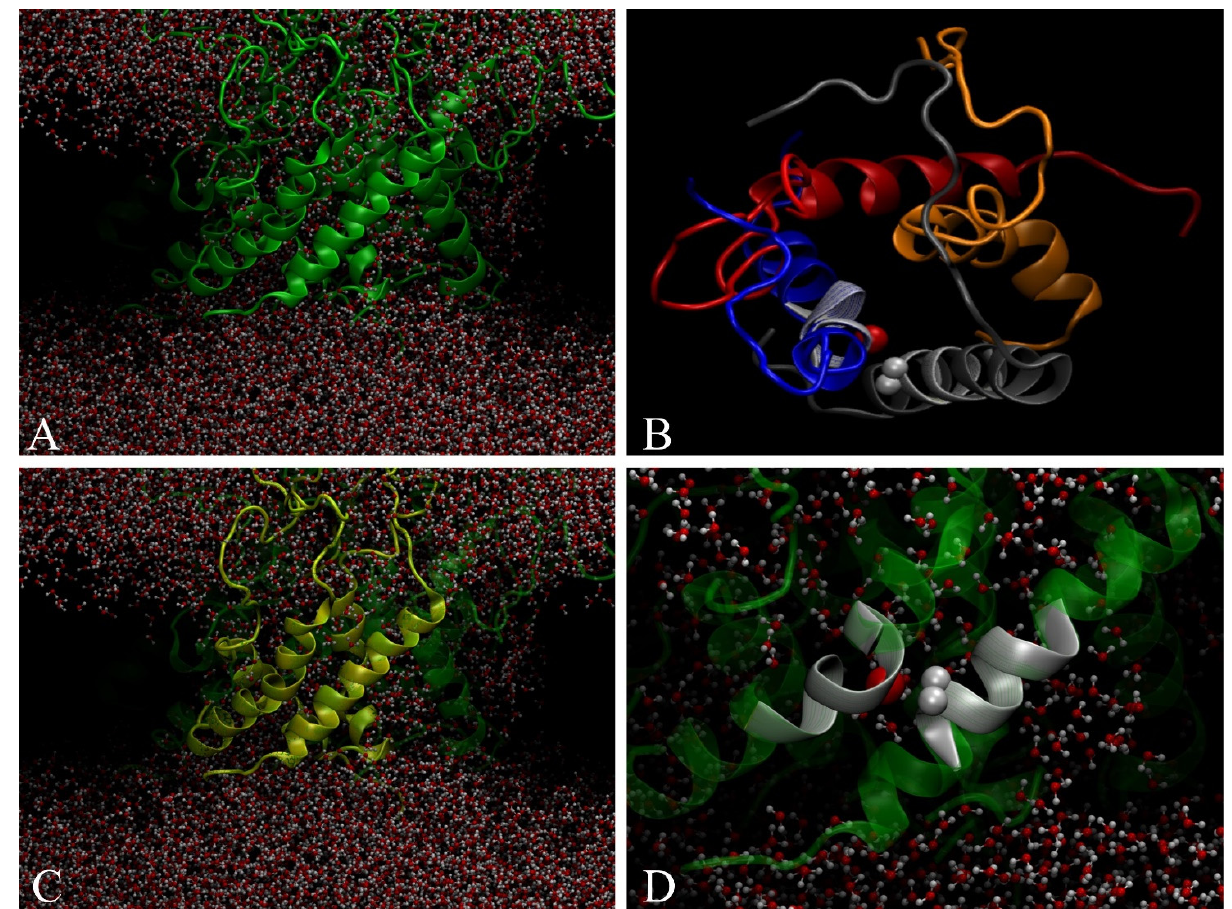
Figure 1. ( A ) 24-mer of A β (1-40) within POPC bilayer forming ion-channel-like pores where water is able to cross the bilayer. ( B ) Top view of tetramer ion-channel-like pore. ( C ) Tetramer forming structured pore. ( D ) Two crossed a-helix inside the tetramer by forming an angle of 39 ± 5 degrees. Gray spheres represent two C α -hydrogen of Gly and the red sphere represents C=O carbonyl oxygen.